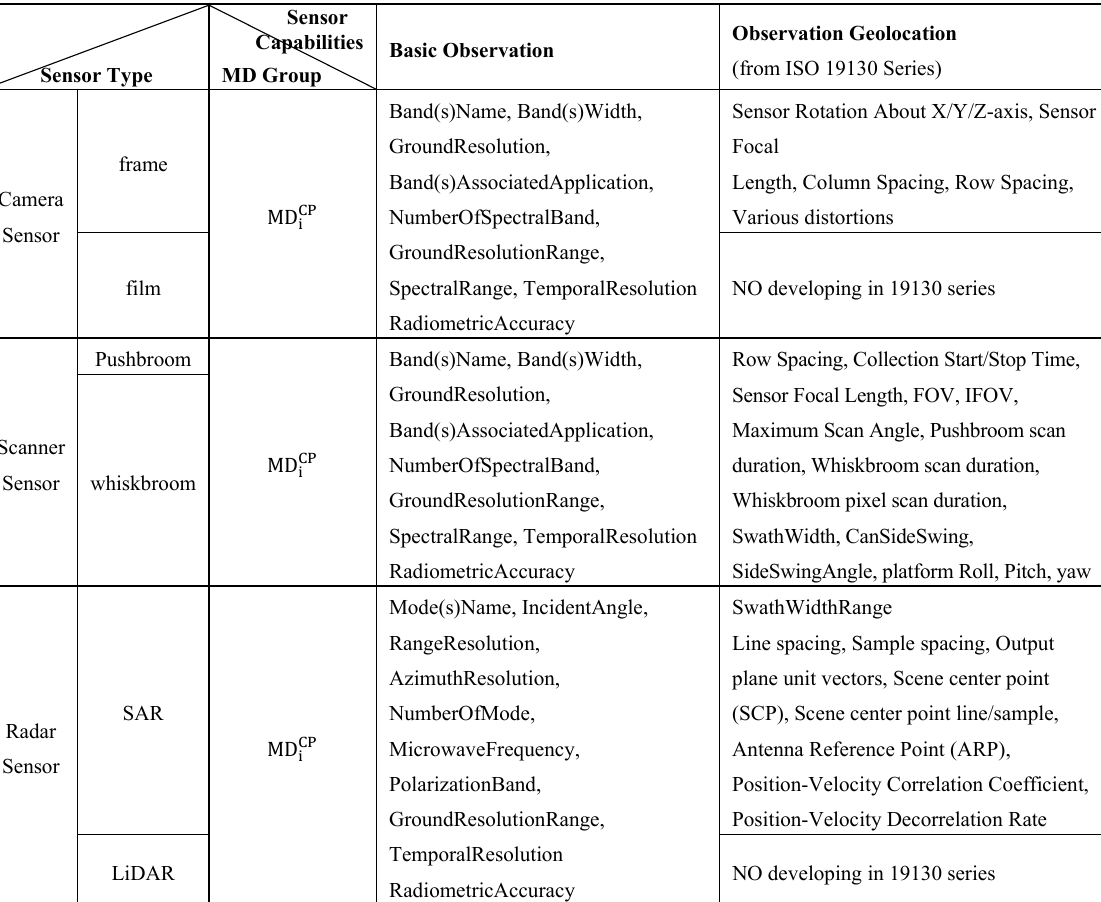
Table 2. MD (cid:2919)(cid:2887)(cid:2900) for a specific type of remote sensing satellite